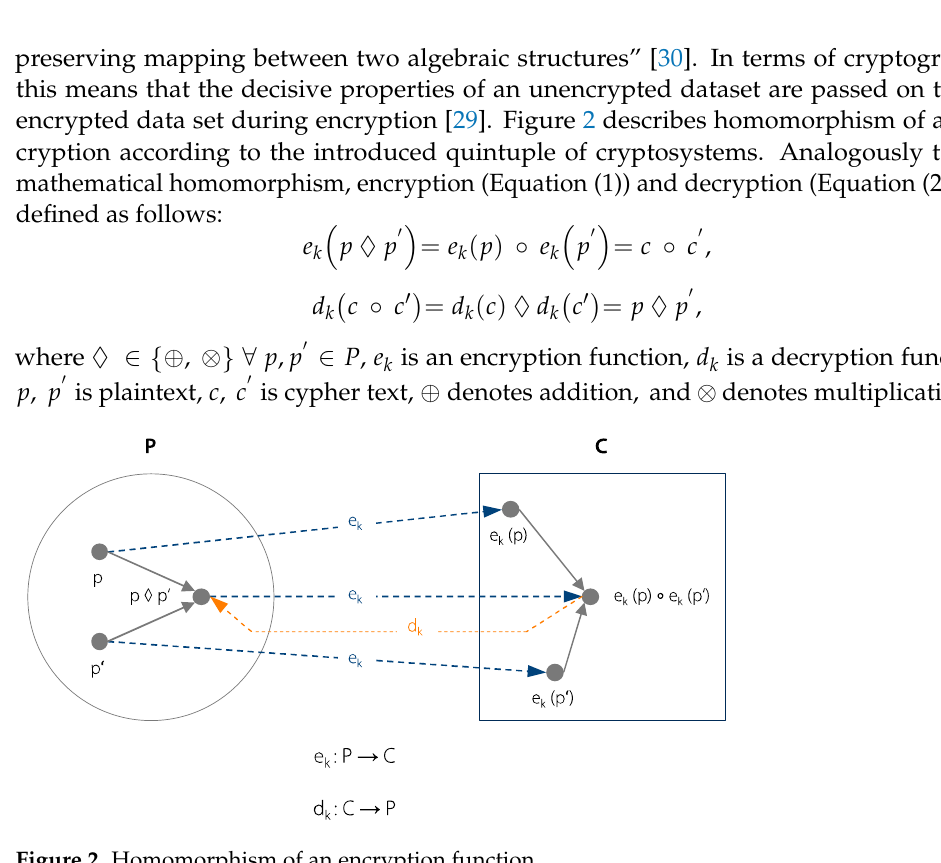
Figure 2. Homomorphism of an encryption function.